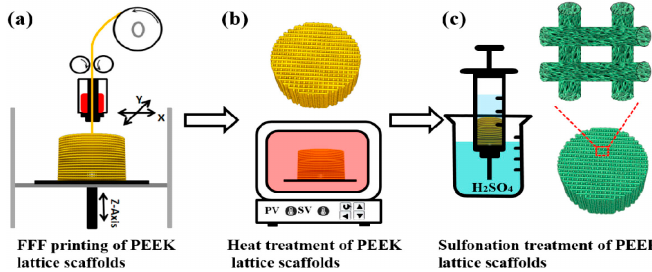
Figure 28. Schematic illustration showing micropores formation on the filaments of FFF-printed PEEK lattice scaffolds. ( a ) FFF printing, ( b ) heat treatment, and ( c ) sulfonation of PEEK scaffolds. Reproduced from [216] with permission of Elsevier under a Creative Commons license.